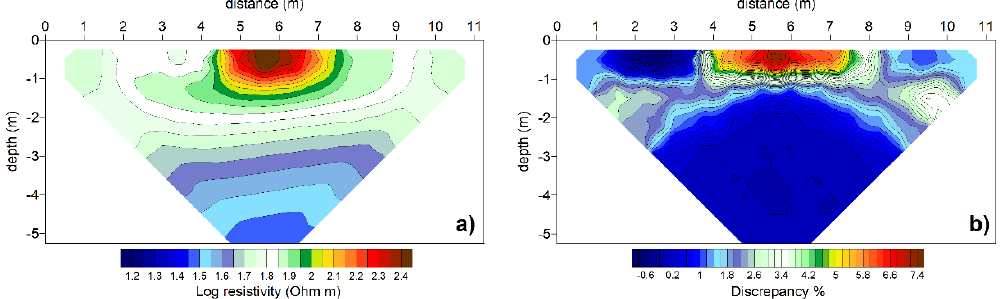
Figure 12. E-PERTI section resulting from the estimation of ρ m with a linear best-fit procedure applied point by point to the resistivity values belonging to the PERTI sections in Figure 11 ( a ) and discrepancy section between the E-PERTI section in ( a ) and the classical PERTI section in Figure 10b ( b ).